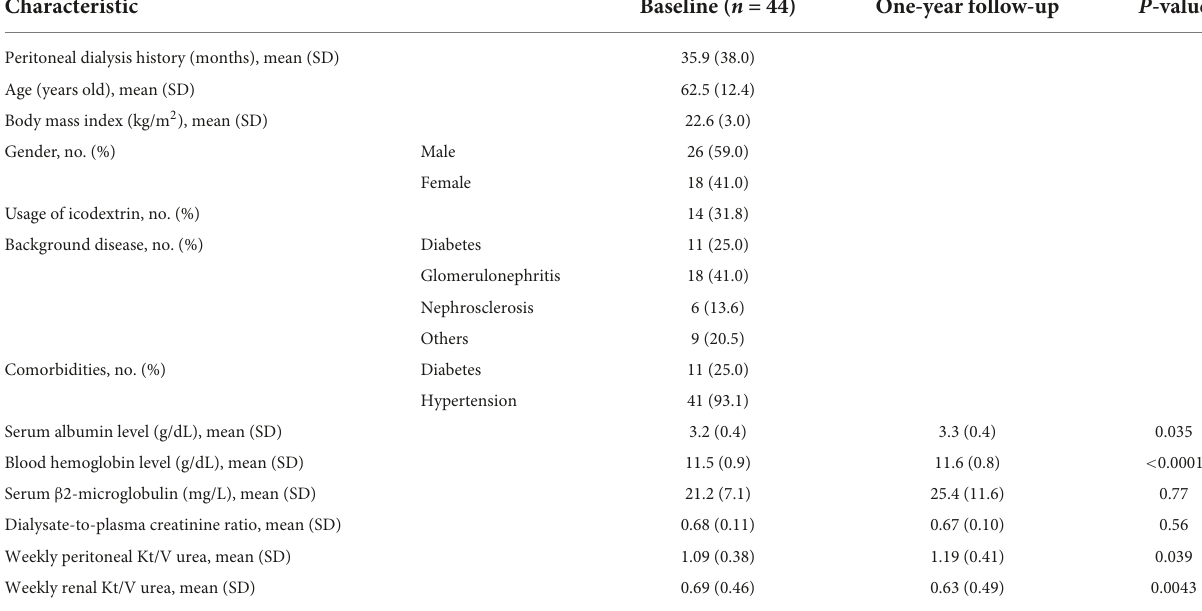
TABLE 1 Background characteristics of peritoneal dialysis (PD) patients ( n = 44).